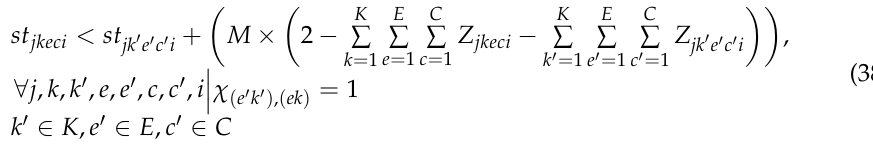
Figure 7. The chains between the service center and other departments.